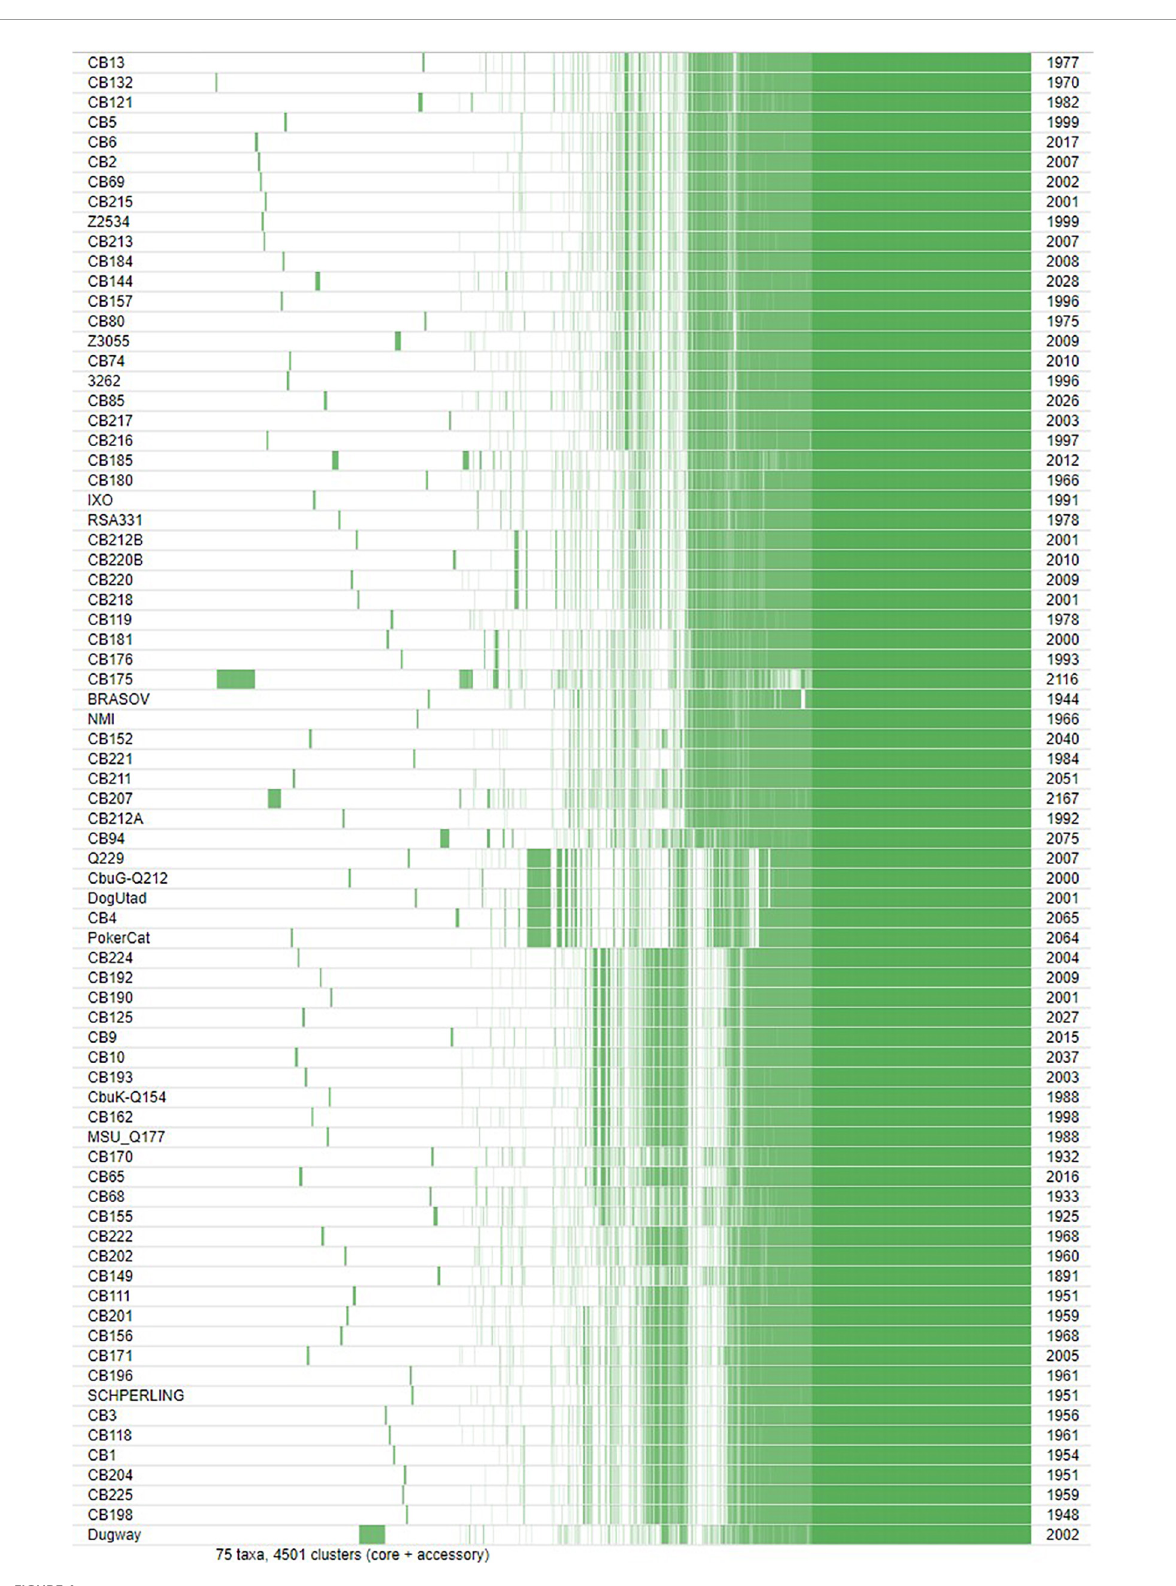
FIGURE4 Presence/absence gene matrix of the 75 studied